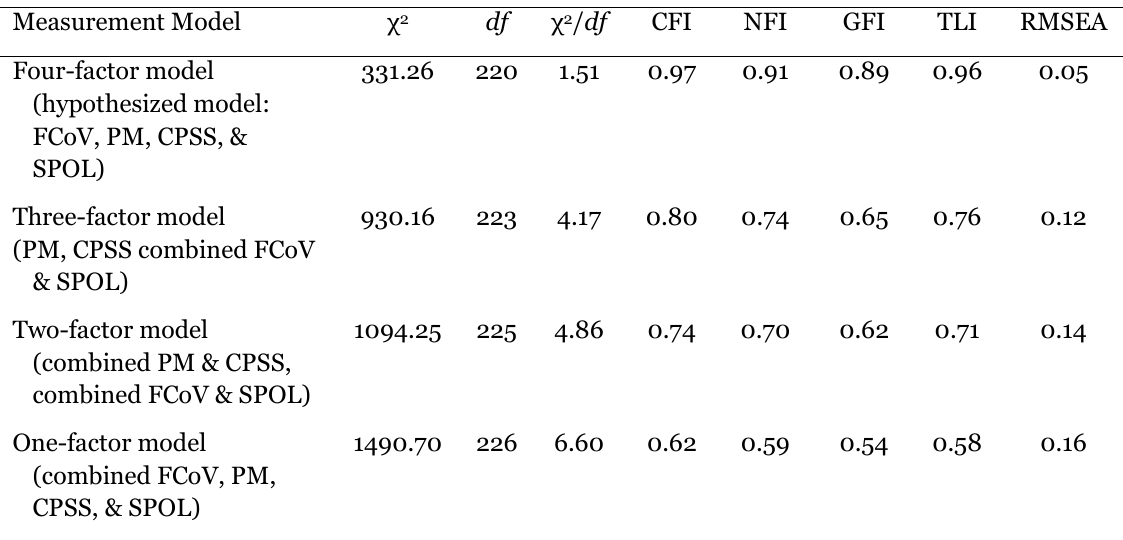
CFA-Model Fit Indices for Study Variables